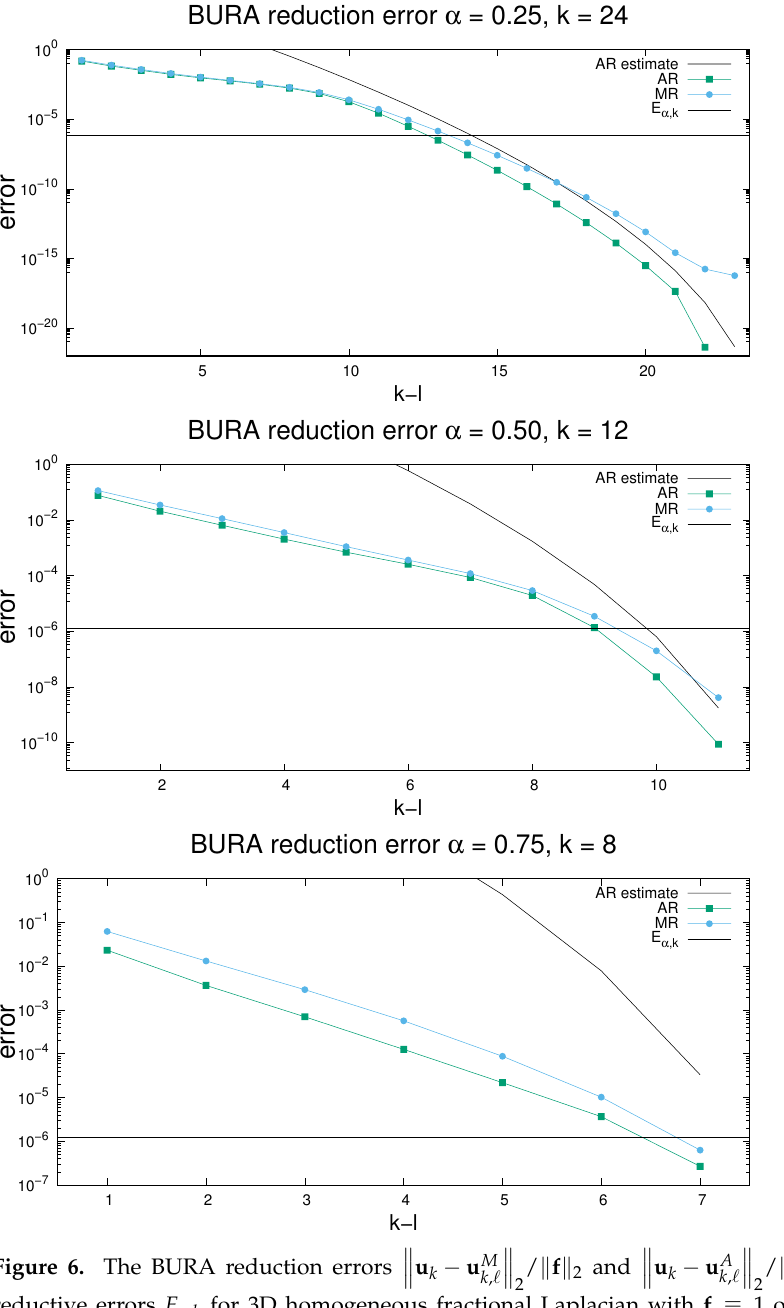
Figure 6. The BURA reduction errors reductive errors E α , k for 3D homogeneous fractional Laplacian with f ≡ 1 on [ 0,1 ] 3 . Uniform mesh with h = 1/128 is